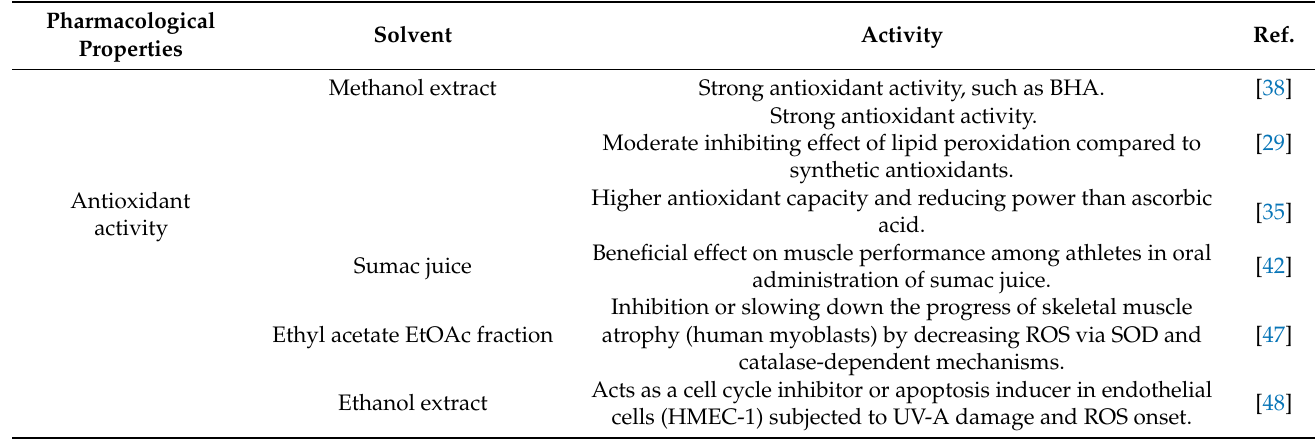
Table 2. Biological activities and pharmacological properties of fruit extracts of sumac ( Rhus coriaria